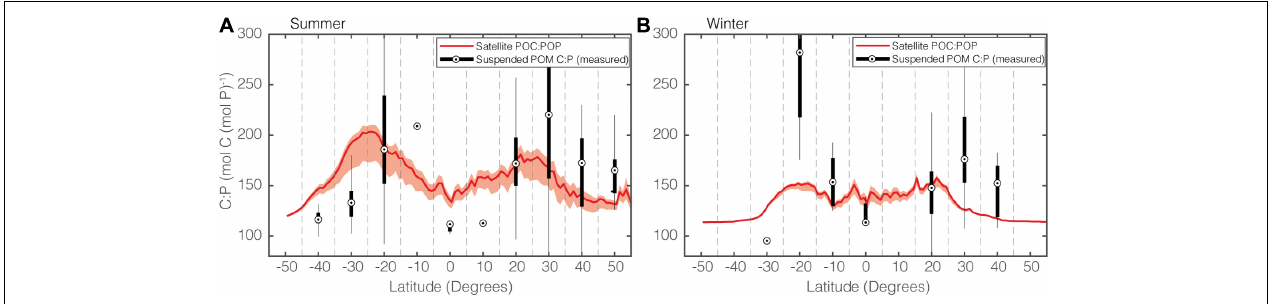
FIGURE 7 | Comparisons of modeled and observed zonal POC:POP for (A) summer and (B) winter. The solid red curve shows the median POC:POP of the satellite-informed estimates, and shading shows the range. The black dot in the box and whisker plot show the median POC:POP, and the upper and lower edges of each box correspond to the upper and lower quantiles. The vertical tails correspond to a 95% confidence interval. When the sample size is 1, the sample variance could not be estimated, and only the dot representing unique POC:POP is shown (e.g., 10 ◦ N during Summer). Note that the satellite-informed POC:POP ratios are global latitudinal averages, whereas the measured POC:POP are averages of discrete data points.